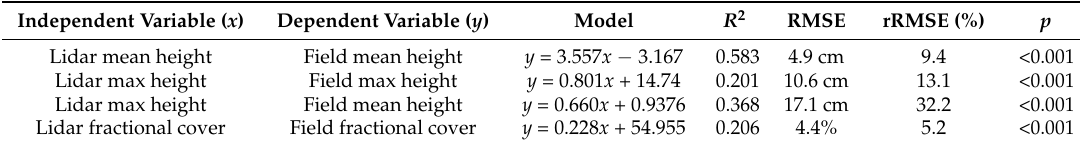
Table 3. Results of linear and nonlinear regression analyses between the lidar-derived parameters and field-measured